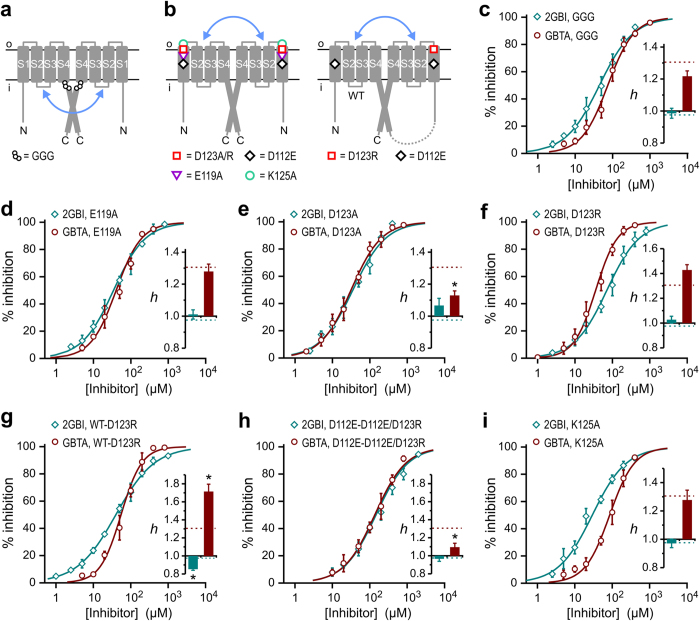
Exploring the roles of CCD and S1 in coupling between open subunits.(a) Schematics of an Hv1 dimer with a triple glycine mutation at the inner end of S4 designed to disrupt intersubunit coupling mediated by the cytoplasmic coiled-coil domain (blue arrow). (b) Schematics of Hv1 dimer and linked dimer bearing the indicated mutations designed to test the involvement of the S1 segment in the coupling between subunits (blue arrow). (c–h) Concentration dependences of inhibition of the indicated constructs by 2GBI (teal) and GBTA (dark red). Each point represents the average inhibition from 3 to 10 measurements ± S.D. Curve lines are Hill fits used to obtain apparent Kd values (see Supplementary Table 1). Hill coefficients in inset histograms were determined as described in the methods section (see Supplementary Figs 3 and 4). Reference h values for Hv1 WT are shown as dotted lines. Asterisk indicates statistically significant difference between mutant and WT channel (p < 0.05/14, see methods).